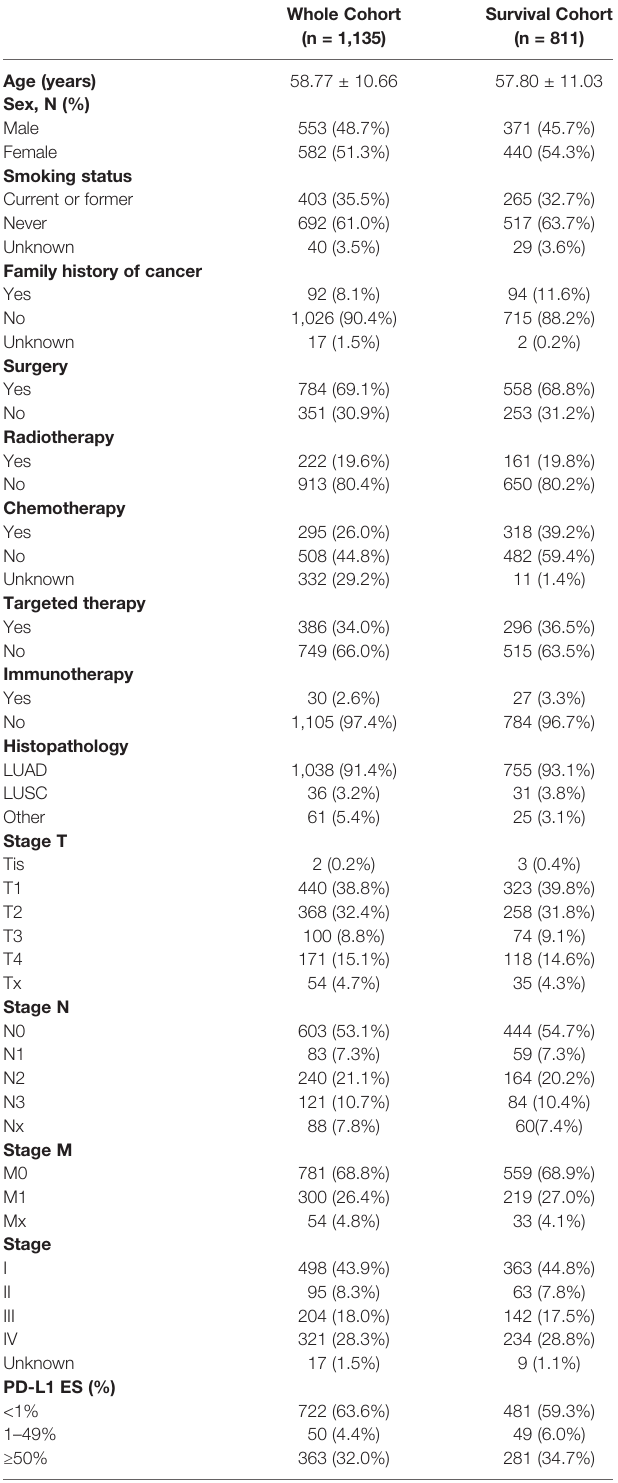
TABLE 1 | Clinical characteristics of patients used to measure PD-L1ES and survival